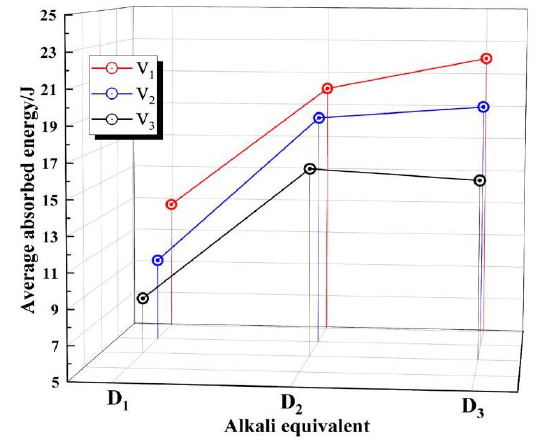
Figure 5. Trend of the average value of Ep.